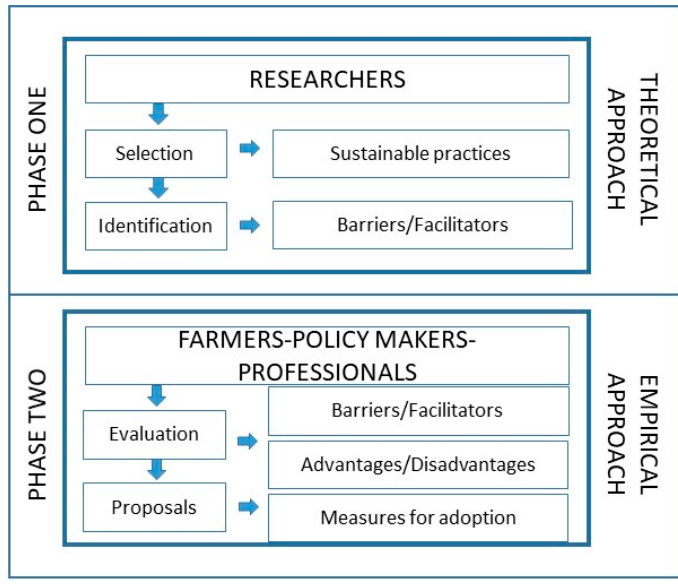
Figure 2. Conceptual framework.